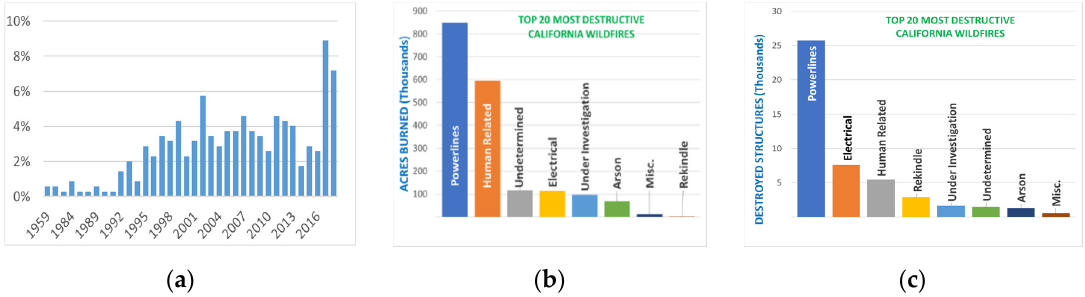
Figure 1. Wildfires by power line failures ( a ) Proportion through time. ( b ) Acres burned. ( c ) Structures destroyed. Data from CalFire